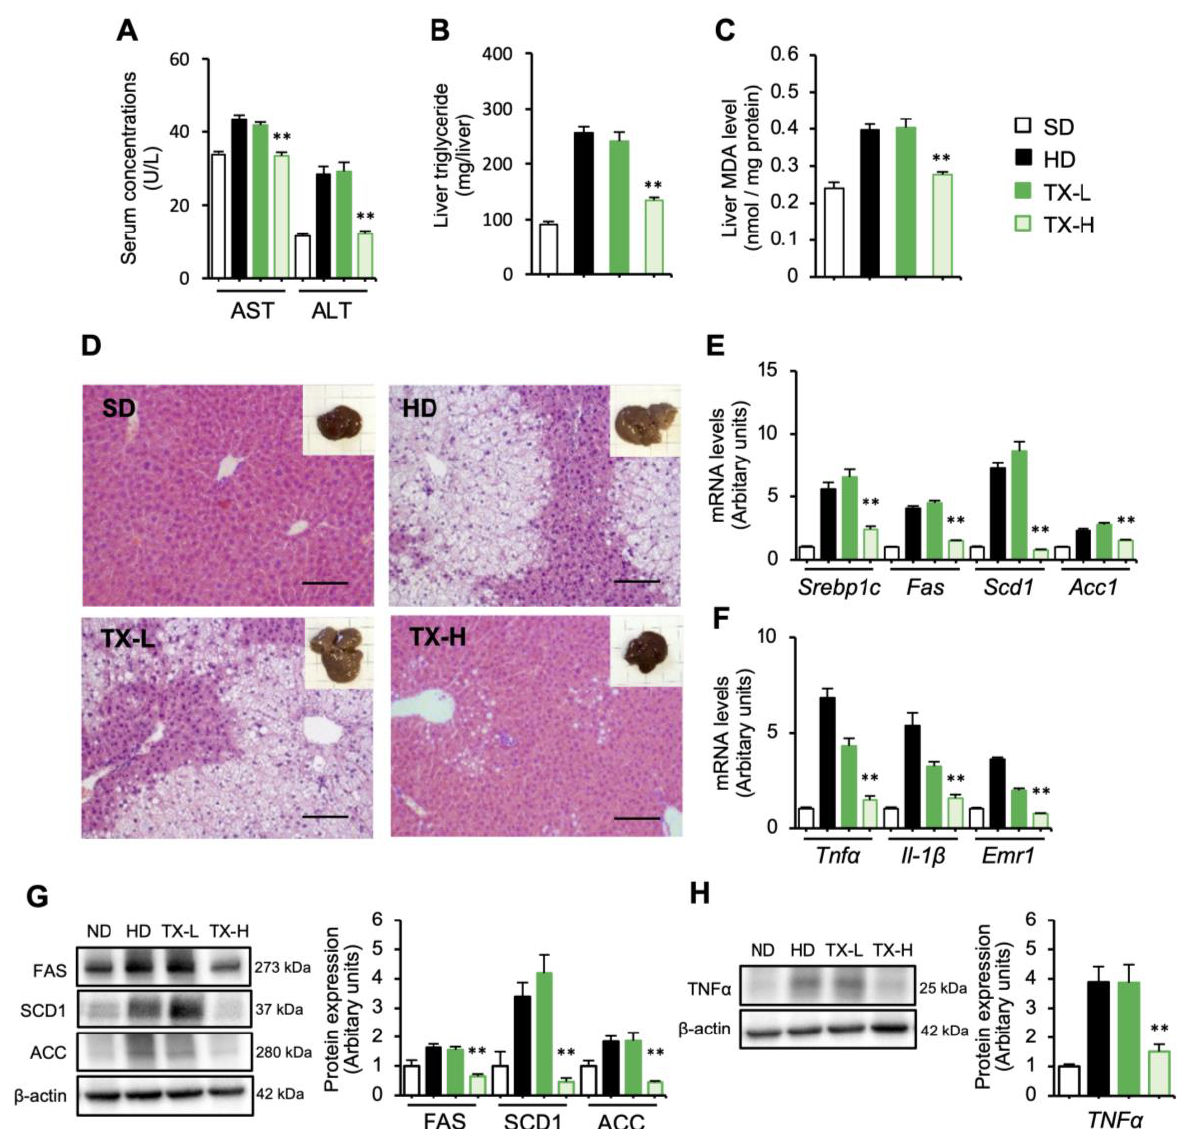
Figure 2. Preventive effects of Taxifolin on hepatic steatosis in diet-induced obese mice. White square: SD; black square: HD; dark-green square: TX-L; light-green square: TX-H. n = 6 in each group. ( A ) Serum concentrations of AST and ALT after 12 weeks of HD feeding; ( B , C ) hepatic triglyceride and MDA contents; ( D ) hematoxylin and eosin (HE) staining of the liver. Insets: gross appearance of the livers. Scale bars: 100 µ m. ( E , F ) Expression levels of genes related to lipogenesis ( Srebp1c , Fas , Scd1 , and Acc1 ) and inflammation ( Tnf α , Il1b , and Emr1 (F4/80)) in the liver; ( G , H ) immunoblot analysis of the protein expression levels related to lipogenesis (FAS, SCD-1, and ACC) and inflammation (TNF α ) in the liver. β -actin was used as a loading control. Values are presented as the means ± SEM; n = 6; significant differences: ** p < 0.01 vs.